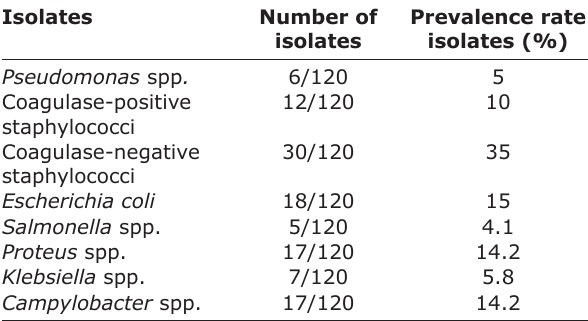
Prevalence rate isolates isolates (%)